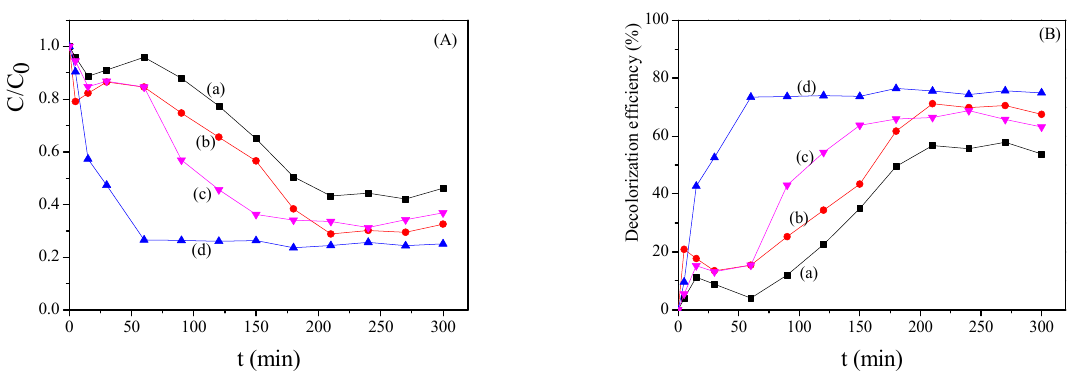
Figure 9. Relative Tar concentration vs. reaction time for Mn-containing ( A ) and decolorization efficiency ( B ) as a function of reaction time for the bimetallic catalysts: (a) CuFe-NaY; (b) FeCu-NaY; (c) FeMn-NaY and (d) MnFe-NaY. Reaction conditions: 50 mg of catalyst, V Tar = 250 mL, C 0 = 30 ppm, initial pH = 3.00, C H2O2 = 12 mM, T R = 40 ◦ C. Table 4. Catalytic results for Tar degradation on the bimetallic catalysts. Reaction conditions: 50 mg of catalyst, V PY = 250